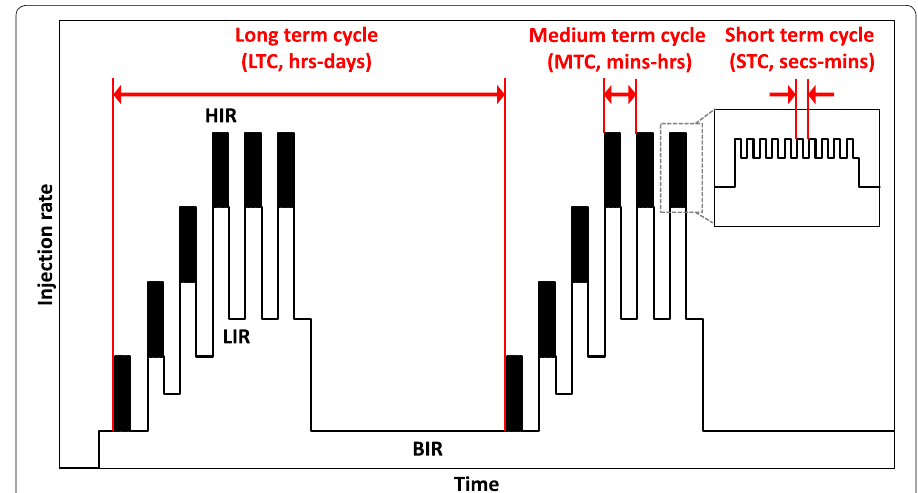
Fig. 3 Cyclic fluid injection protocol with long‑term (LTC), medium‑term (MTC) and short‑term (STC) cycles, and alternating phases of high injection rate (HIR), low injection rate (LIR), and base injection rate